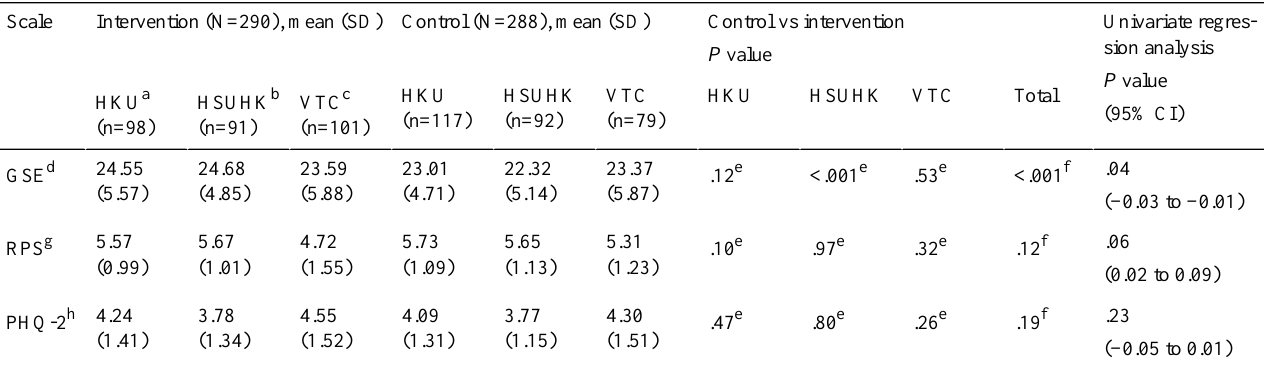
Table 4. Effectiveness of the intervention in participating college students at the 1-month